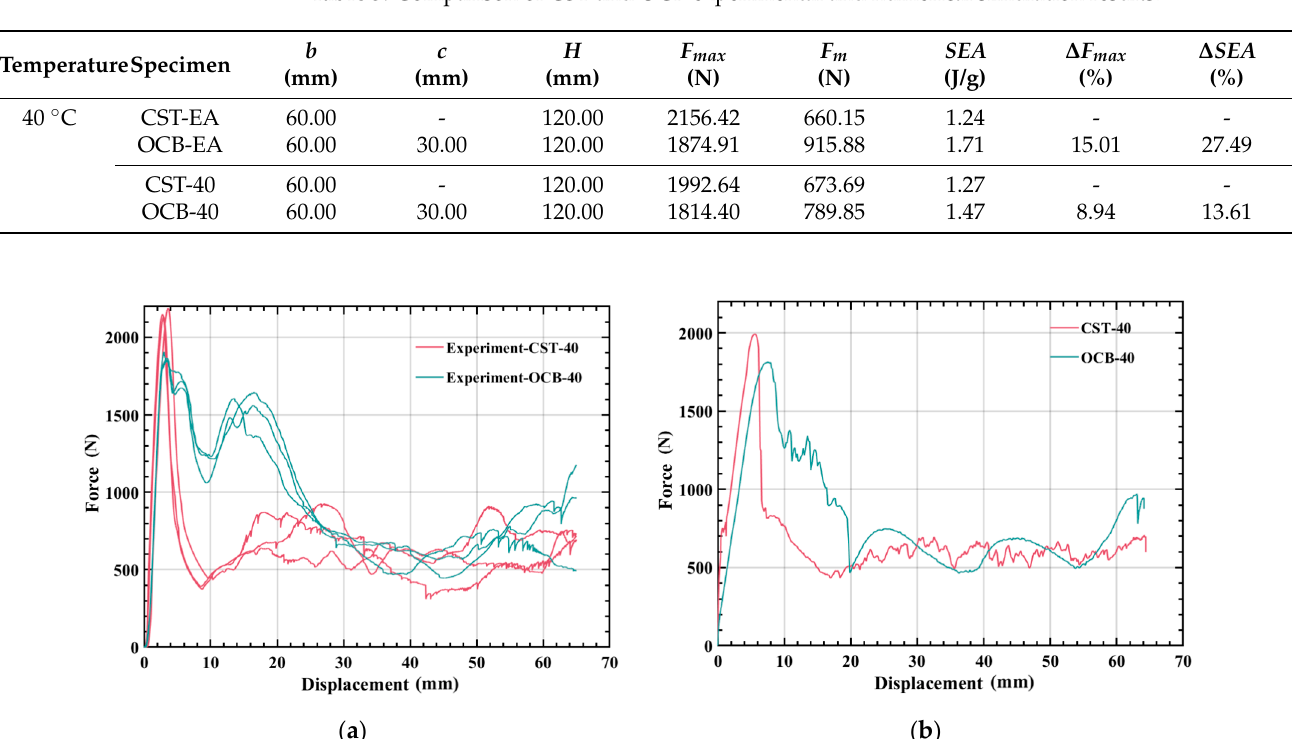
Table 3. Comparison of CST and OCB experimental and numerical simulation results.